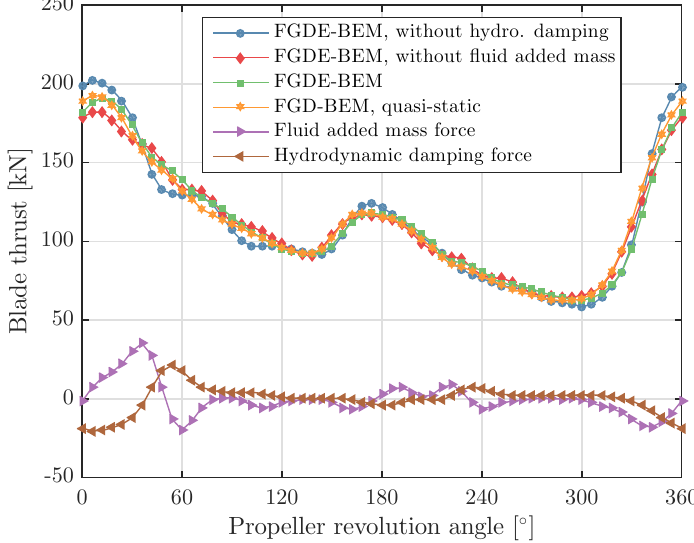
Figure 17. Blade thrust, fluid added mass and hydrodynamic damping force computed with the FGDE-BEM-FEM coupling with and without including the fluid added mass and hydrodynamic damping in the calculations, for the glass–epoxy Seiun–Maru propeller.